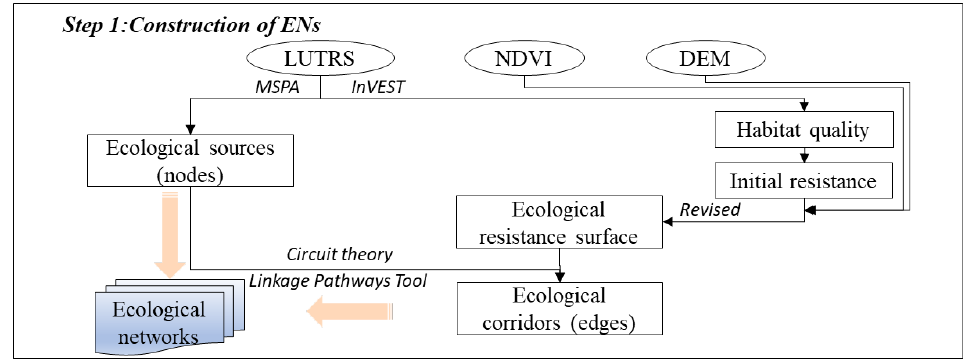
Figure 2. Construction of ENs in